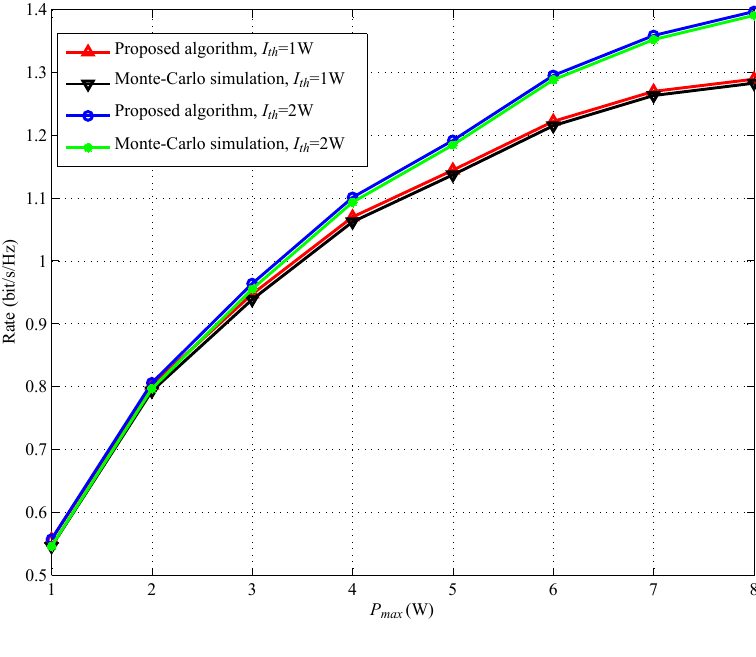
Figure 10. Achievable rate versus P max .